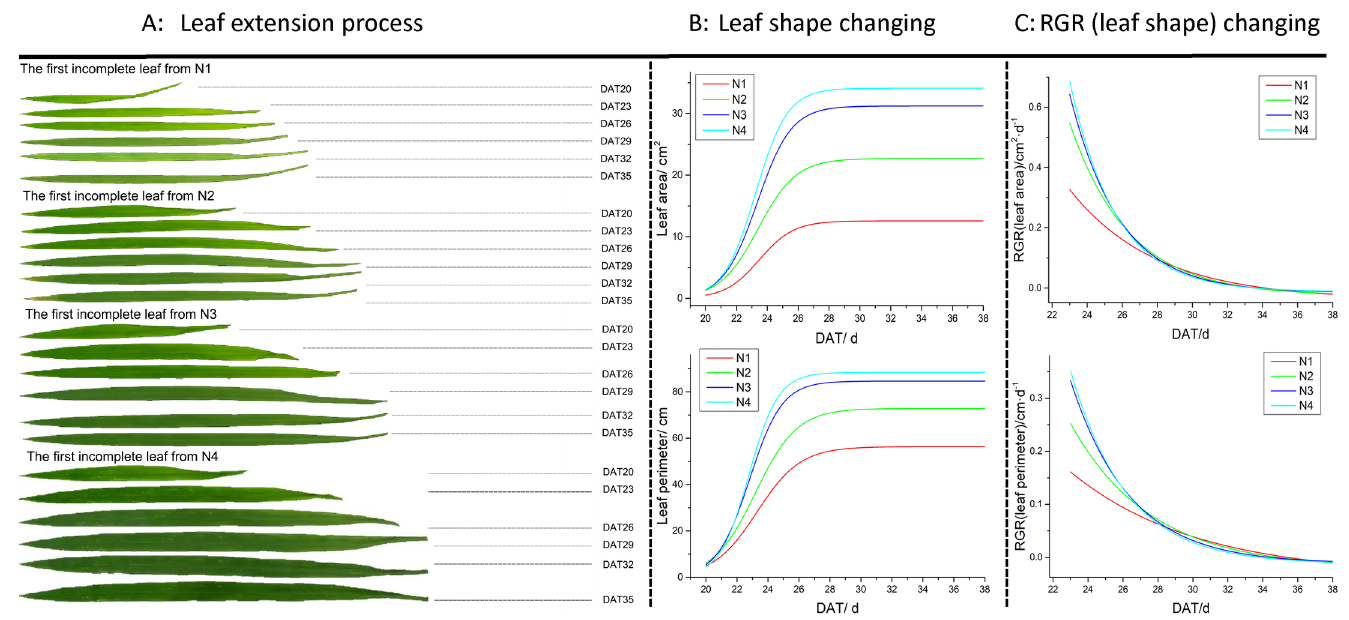
Fig 3. Dynamic changes of the first incomplete leaf in different N